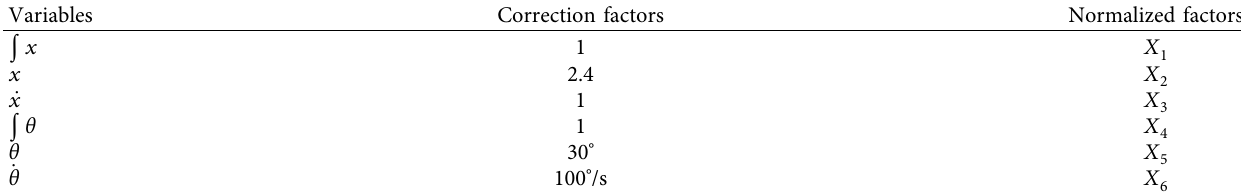
Figure 4: Block diagram of the designed control scheme. Table 1: Values of correction factors corresponding to 􏽒 x, x, _ x , 􏽒 θ , θ , _ θ in FFS.